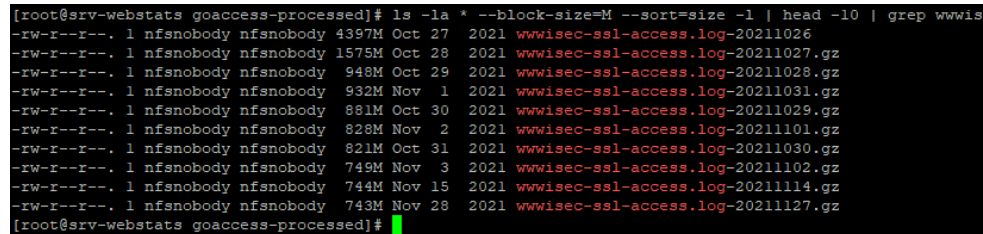
Figure 9. Ten of the biggest log files of all